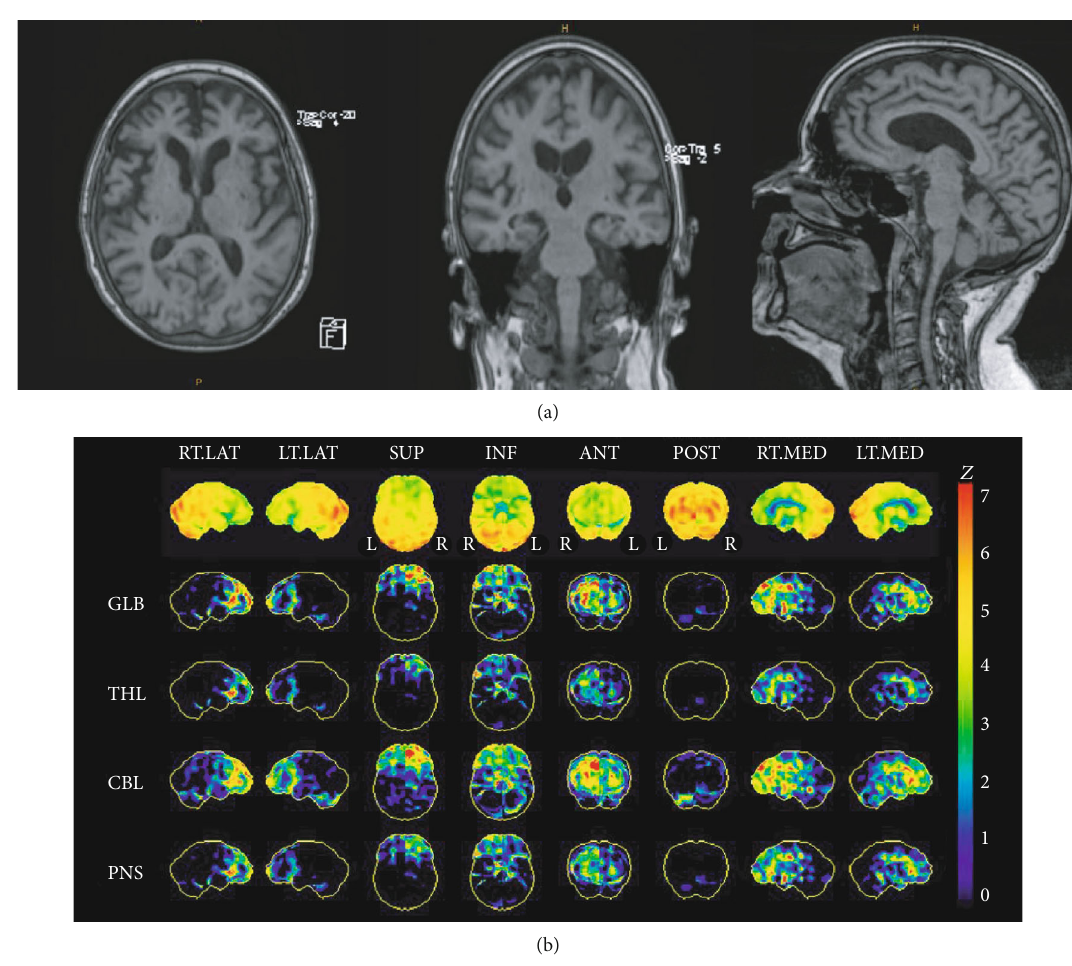
Figure 2: 84F, independent with activities of daily living, MMSE 30/30, ACER 84/100, but occasional odd behaviors noted by children in the recent weeks. Diagnosed with early frontotemporal dementia. (a) Brain MRI — moderate generalized enlargement of the ventricles and surface CSF spaces, particularly a ff ecting the frontal lobes bilaterally. Mild presumed microangiopathic changes and tiny old scattered lacunes. No features of remote microhemorrhages. (b) Brain SPECT — decreased activity is seen predominantly at both frontal lobes. There is also involvement of the anterior and mesial temporal